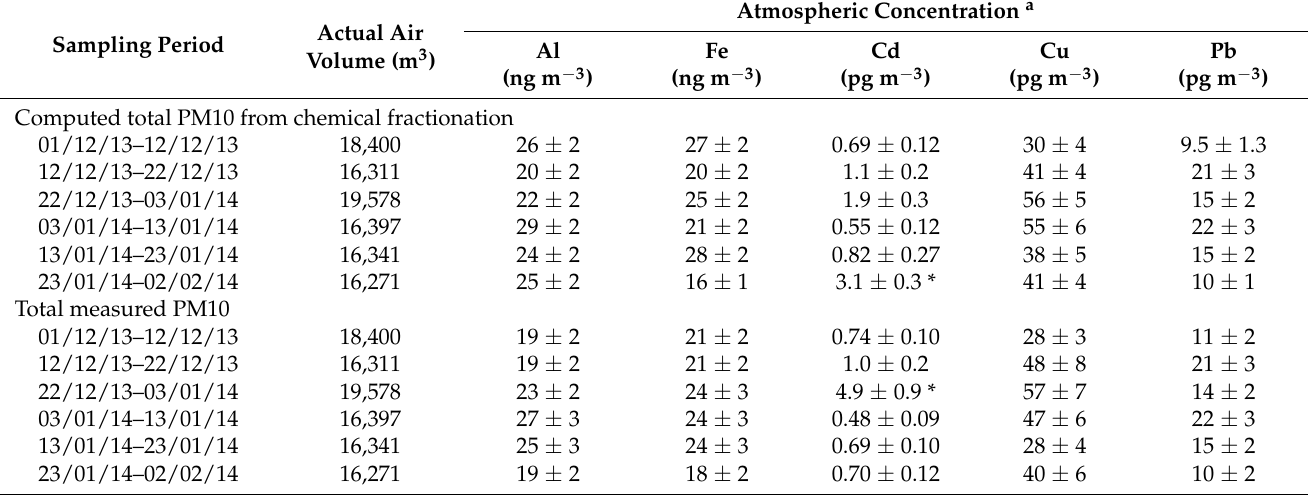
Table 2. Atmospheric concentrations of the studied metals (Al, Fe, Cd, Cu, and Pb) as the sum of different metal fractions (soluble + insoluble fractions) and as direct measurements at Faraglione Camp during the austral summer 2013–2014. Concentrations refer to actual